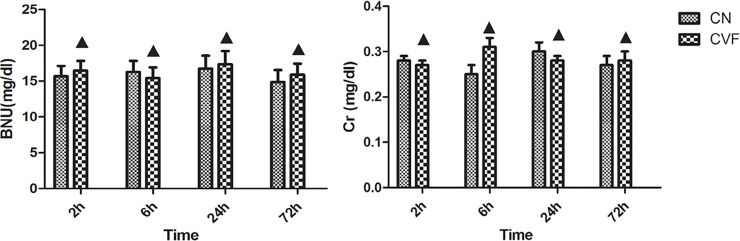
Levels of Serum BUN and Cr.▲ P>0.05 vs. control.